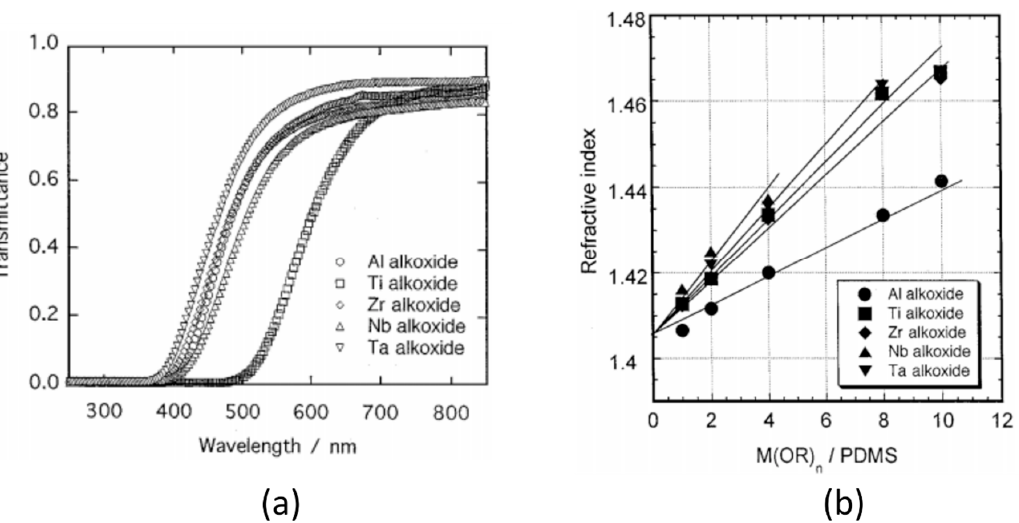
Figure 12. Optical properties of PDMS–O–M hybrids (M = Al, Ti, Zr, Nb or Ta) prepared using M-alkoxides. ( a ) UV-VIS transmittance spectra for hybrids prepared with metal alkoxide to PDMS ratio of 4; ( b ) Change in refractive index with metal alkoxide to PDMS molar ratio for various hybrids. Reproduced with permission from Yamada et al., Journal of Sol–Gel Science and Technology ; published by Kluwer Academic Publishers, 2000.